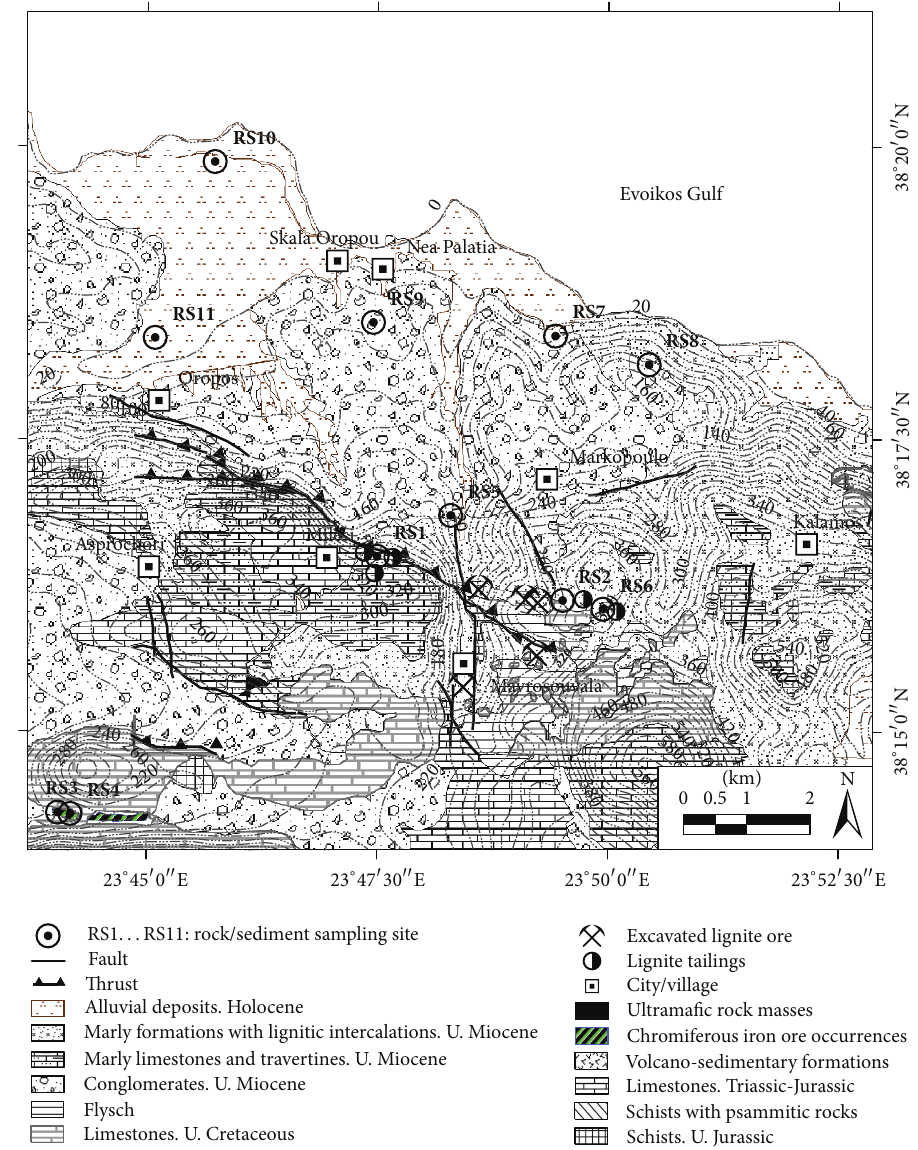
Figure 2: A simplified geological map of the Oropos-Kalamos area [23, 25] showing lignite tailings, excavated lignite ore occurrences, and sampling